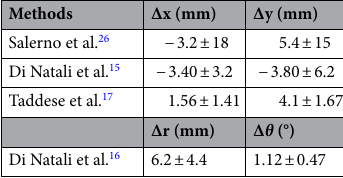
Table 3. Average accuracy of previous methods. The average accuracy presented in mean error ± standard deviation.